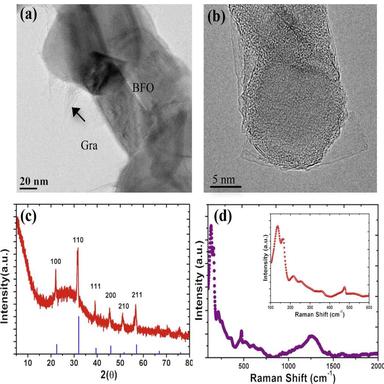
(a) TEM image, (b) HRTEM image, for the BFO/Gra composite. (c) XRD pattern of synthesized BFO (JSPDICSD#20372). (d) Raman spectra for synthesized BFO in wavelength of 100–2000 cm-1, inset 100 to 600 cm-1.